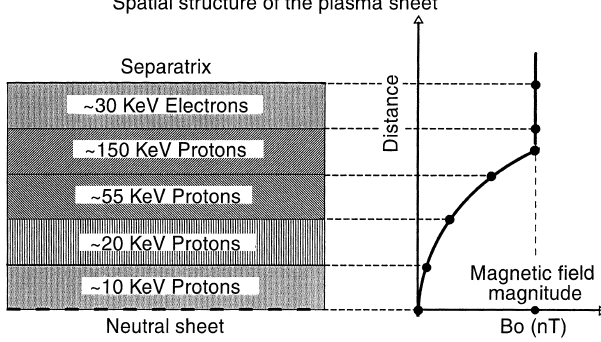
Fig. 5. Sketch illustrating the spatial structure of the plasma sheet. Five successive layers (dependent on energy and species) are encountered as the spacecraft crosses the separatrix moving toward the neutral sheet. Here, the energetic electrons stream exclusively on lobe field lines (characterized by constant magnitude of the lobe magnetic field). The distance scale is arbitrary